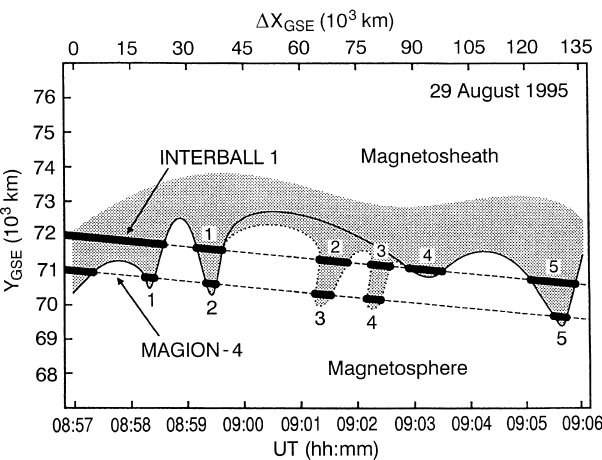
Fig. 7. Schematic drawing of the magnetopause